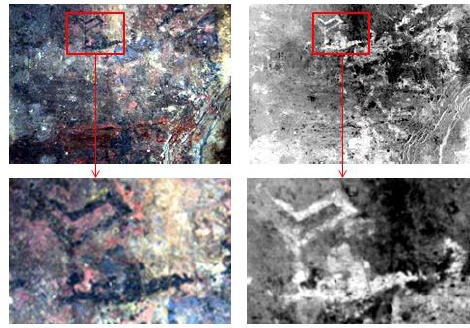
Figure8. Comparison of formula (3) before and